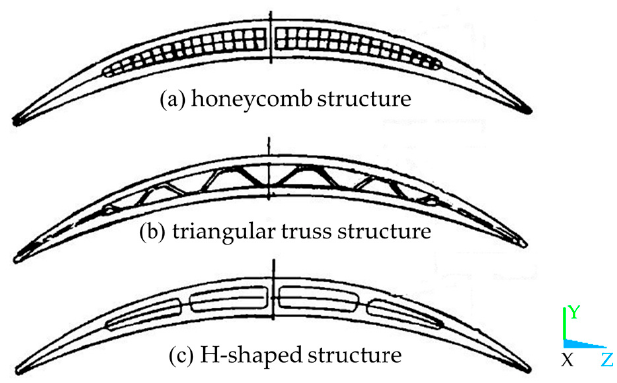
Figure 1. Hollow fan blades with different reinforcing ribs [6 ].